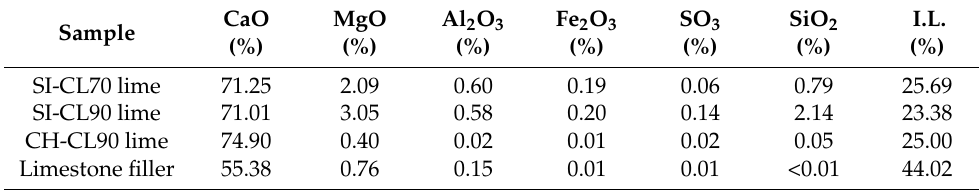
Table 1. Chemical composition of the dry hydrated limes and limestone filler.